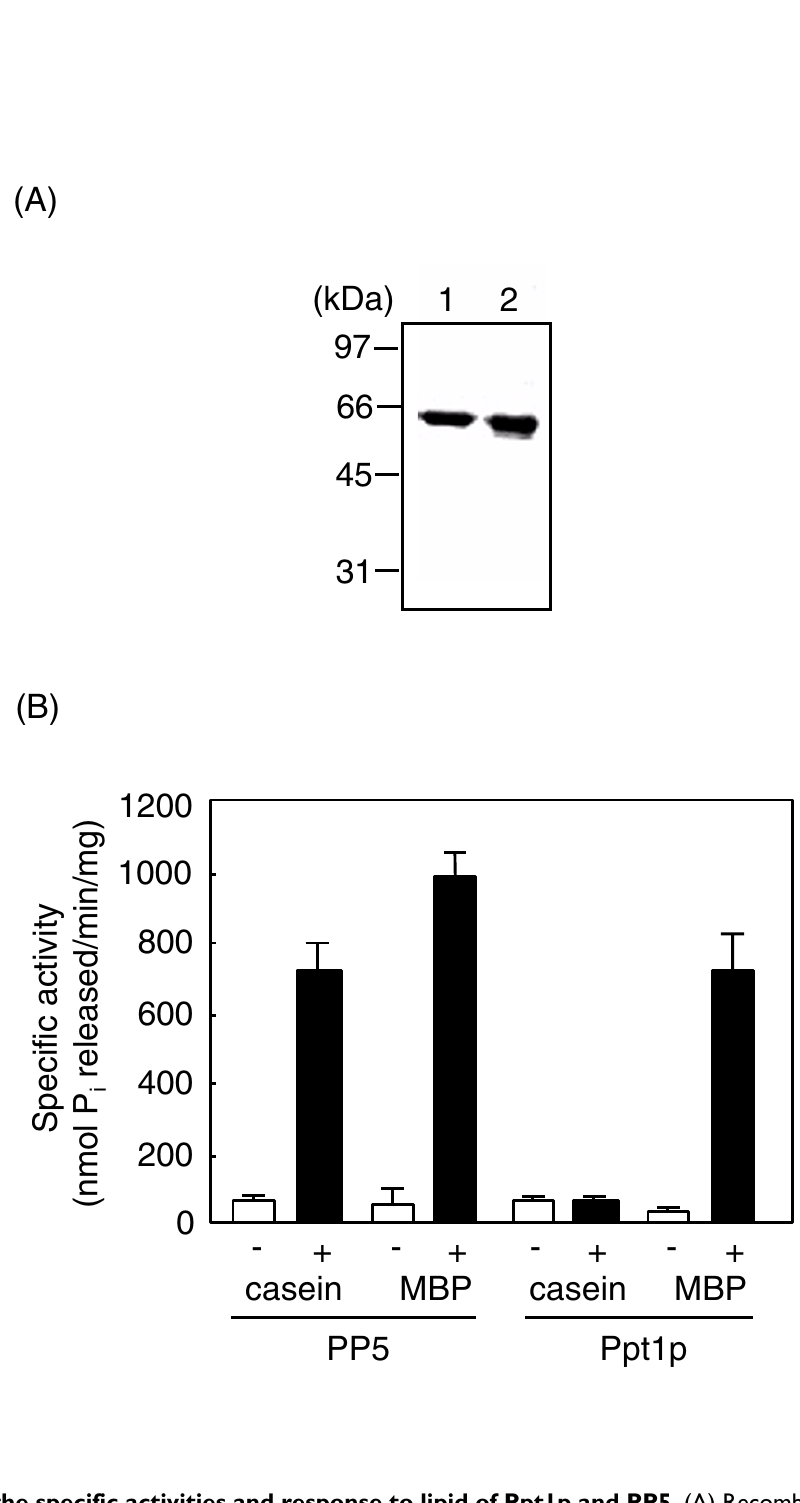
Comparison of the specific activities and response to lipid of Ppt1p and PP5 . (A) Recombinant Ppt1p (lane 1) and Ppt1p (1–504) (lane 2) were expressed in Escherichia coli , purified by GST-agarose chromatography and cleaved with thrombin. Samples containing approximately 7.5 µ g of protein were resolved by SDS-PAGE on a 10% polyacrylamide gel and visualized by Coomassie staining. The migration of molecular weight standards is indicated to the left. (B) Phosphatase activity of Ppt1p or PP5 was assayed for 10 min at 30°C in the absence ( (cid:1) ) or presence ( ■ ) of 250 µ M AA using 10 µ M 32 P-MBP or 32 P-casein as substrate. Data are the average ± S.D. from assays performed in triplicate. Three independent experiments performed under similar conditions yielded similar